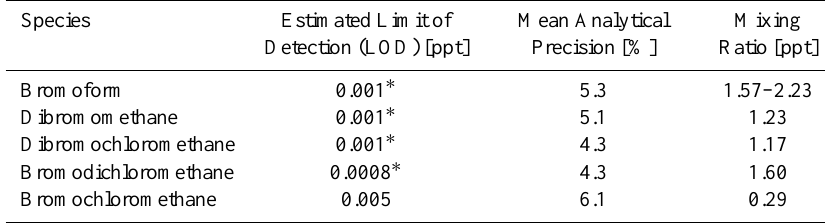
Table 1. Estimated limits of detection (LOD), compound dependant analytical precisions and mixing ratios at which the precision measure- ment was made for short-lived bromomethane species considered in this study (see Sect. 2.1 for further discussion of the working standard).